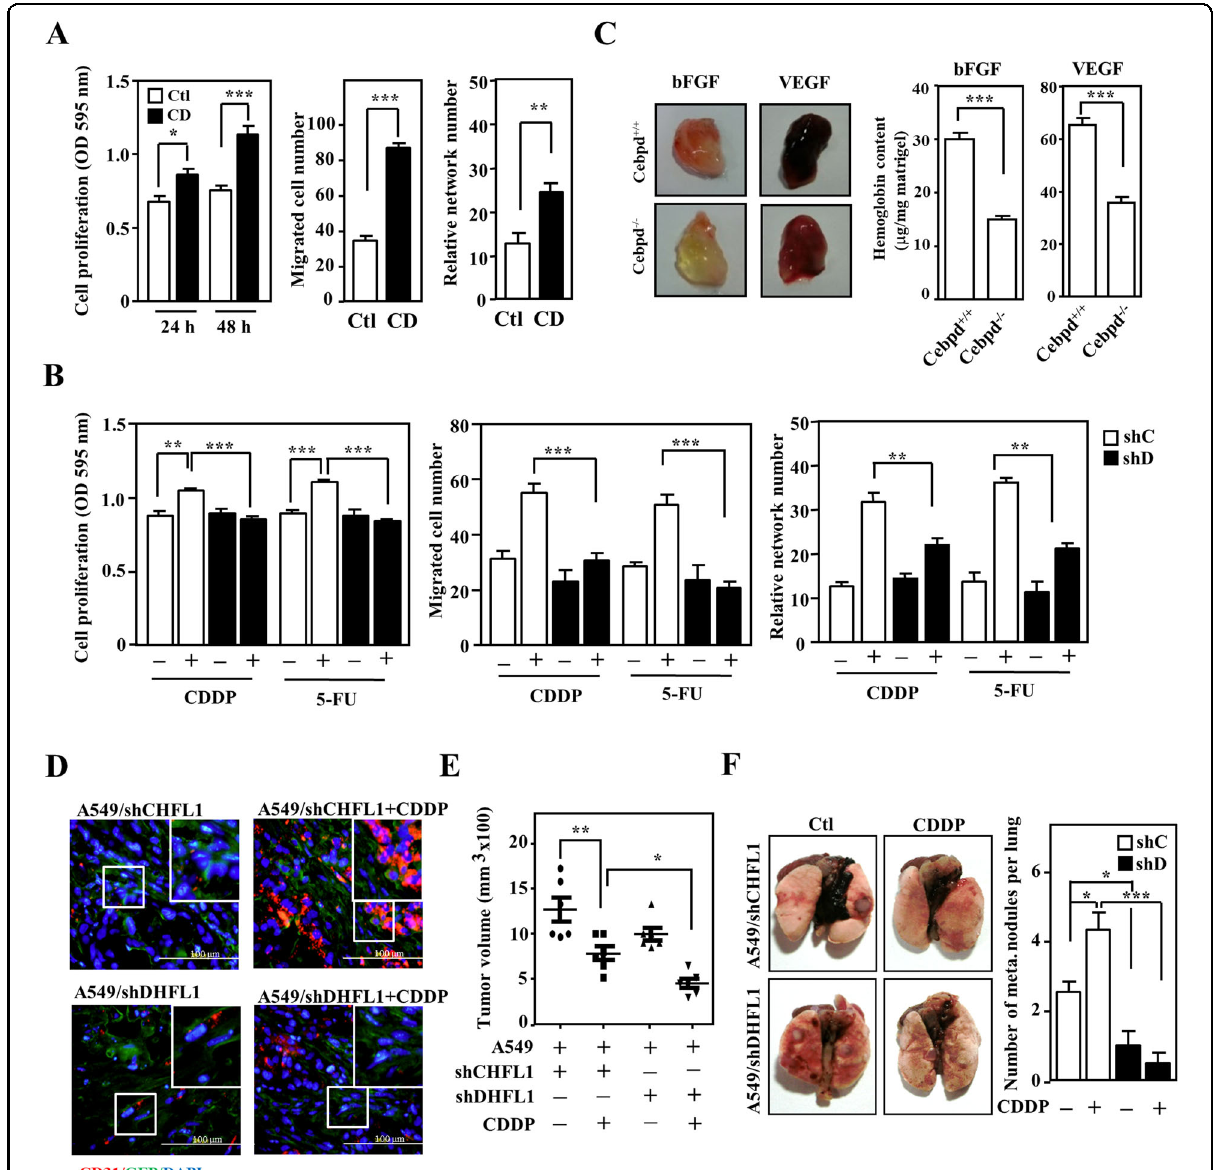
Fig. 2 Activation of CEBPD in fi broblasts contributes to angiogenesis and metastasis of lung cancer. A HUVEC proliferation and migration were assessed using MTT and Boyden chamber assays, respectively. HUVECs were cultured in conditioned medium from HFL1 cells infected with lentivirus bearing pAS3W-control (Ctl) or pAS3W-CEBPD expression vectors (CD). The angiogenic effect was assessed by counting the number of intersections between branches of HUVECs grown in conditioned medium. The data are expressed as the mean ± S.D. Statistical analysis was performed using the Student ’ s t test: * p < 0.05, ** p < 0.01, *** p < 0.001 versus the control group. B Assays to assess proliferation, migration, and in vitro tube formation were conducted. HUVECs were cultured with conditioned medium from HFL1 cells infected with sh β -galactosidase (shC) or shCEBPD (shD) lentiviruses as described in materials and methods. The data are expressed as the mean ± S.D. Statistical analysis was performed using one-way ANOVA followed by the Tukey ’ s multiple comparison test. ** p < 0.01, *** p < 0.001. C Cebpd + / + (WT) and Cebpd – / – (KO) mice were subcutaneously inoculated with 800-ng/ml bFGF or 150-ng/ml VEGF Matrigel plugs. After 5 days, the mice were sacri fi ced, and the Matrigel plugs were removed to assess the newly formed blood vessels; hemoglobin levels were measured in the plugs using a Drakin ’ s reagent kit ( n = 3 per group). The data are expressed as the mean± S.D. Statistical analysis was performed using the Student ’ s t test: *** p < 0.001 versus the control group. D A549 cells mixed with shC-GFP or shD-GFP HFL1 cells were inoculated subcutaneously into the dorsal rear fl anks of NOD-SCID mice, and the mice were treated with or without CDDP (5mg/kg). The mice with A549-xenografted tumors were sacri fi ced in the 12th week. Tumor tissues were stained for CD31 (red) and GFP (green), and nuclei were stained with DAPI (blue). E Tumor volume was measured with external calipers and calculated using the standard formula: V = ( w × l 2 ) × 0.52, where l is the length and w is the width of the tumor ( n = 6 per group). F The number of metastasis nodules from A549- xenografted tumors in the lungs was examined. Three independent experiments were performed in triplicate. The data are expressed as the mean ± S. D. Differences among groups were analyzed with one-way ANOVA followed by the Tukey ’ s multiple comparison test. * p < 0.05, ** p < 0.01, *** p <